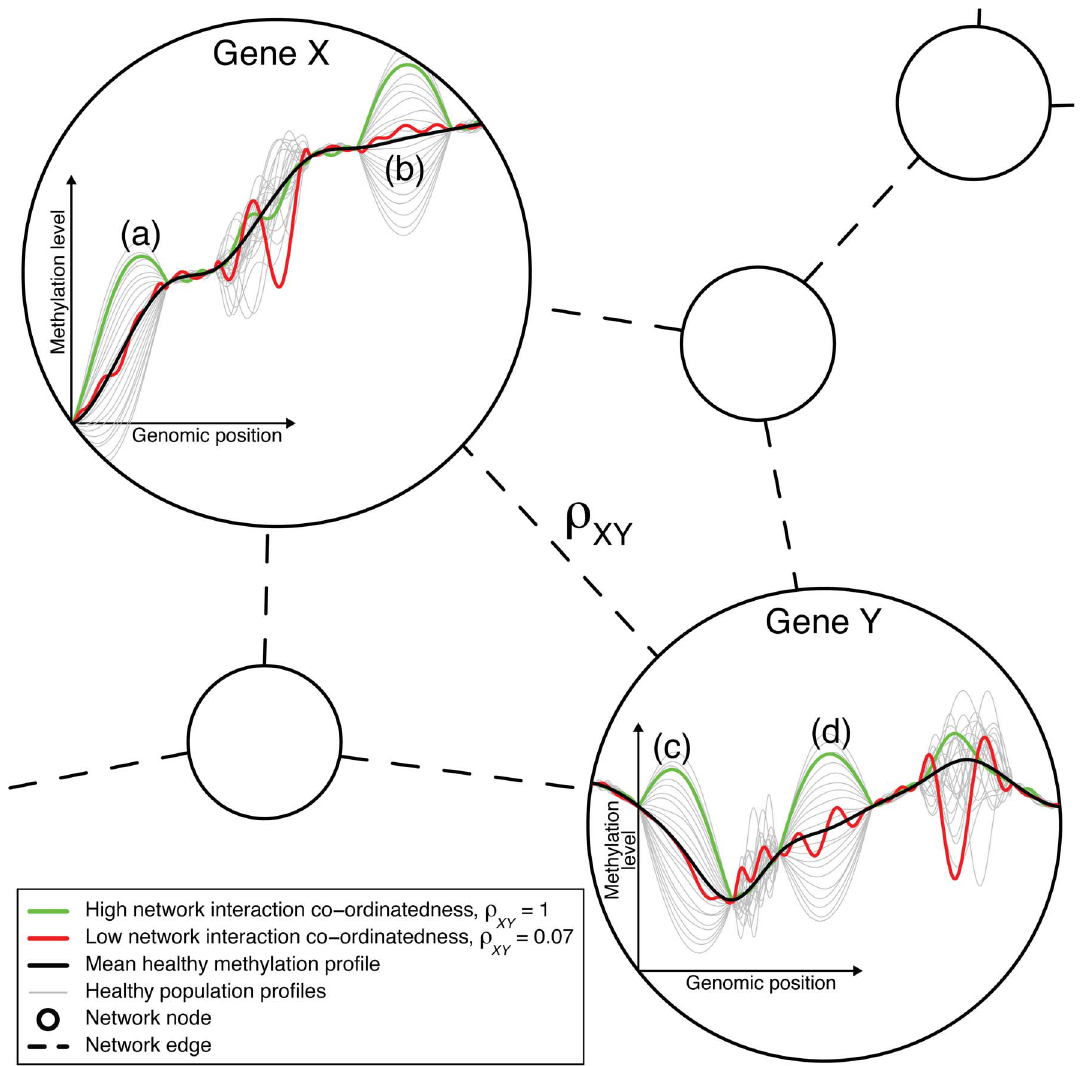
Figure 1. The DNA methylation network interaction measure. A combination of the variation of the healthy methylation profiles in regions (a) and (b) of gene X explains well/is well-explained by a combination of the variation of the healthy methylation profiles in regions (c) and (d) of gene Y. The green cancer sample varies by a large amount about the mean methylation profile and in a typical way in these regions in both genes. Hence, the green sample corresponds to a high level of network interaction co-ordinatedness, as measured by the DNA methylation network interaction measure, r XY ~ 1 . The variation in the other regions of these genes do not well-explain each other, and so the red sample, which varies by a large amount in these other regions and varies less and in an atypical way in regions (a)–(d), corresponds to a low level of network interaction co- ordinatedness, r XY ~ 0 : 07 . Genes X and Y are likely to have different numbers of methylation measurement locations (i.e., variables X and Y are of different dimension). The ordering of the measurement locations has no influence on the calculation of r , as long as the ordering is consistent across samples. based mostly on different samples from the same cancer type. Absolute values of these correlation measures are compared, because negative values mean different things in relation to the DNAm network correlation measure, and to the correlation coefficient of the gene expression data. For each data set, a Spearman correlation test comparing these network correlation measures across all pairs of genes is very significant, with p ƒ 2 : 3 | 10 { 17 for all five data sets considered. Hence, it is concluded that a major component of the interactive behaviour quantified by the DNAm network correlation measure is the interactive (co-regulatory) behaviour corresponding to gene expression, at the mRNA level.